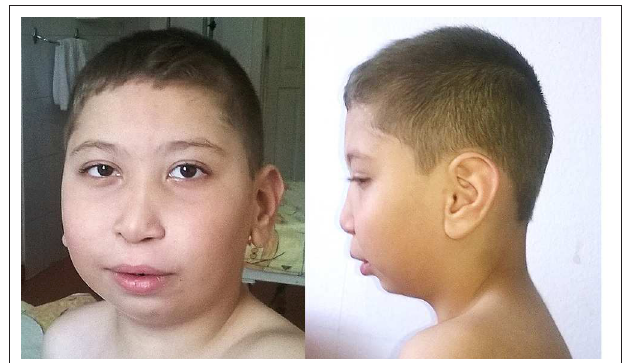
FIGURE 1 | Patient face and profile at the age of 7 years.